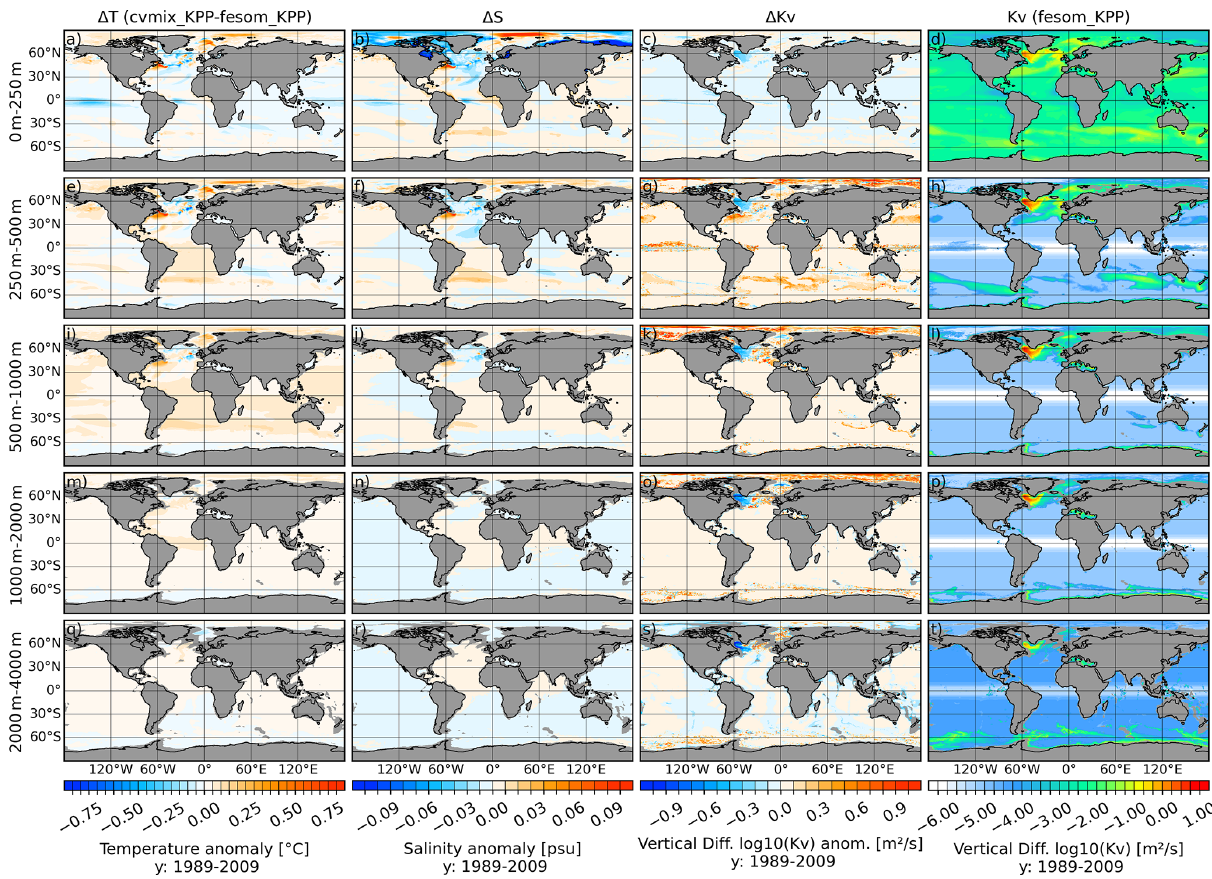
Figure 9. Temperature ( a, e, i, m, q ), salinity ( b, f, j, n, r ) and vertical diffusivity ( c, g, k, o, s ) difference between cvmix_KPP and the original fesom_KPP implementation, as well as the absolute vertical diffusivity values ( d, h, l, p, t ) for fesom_KPP averaged for the period 1989 to 2009. The panels show, from top to bottom, the vertically averaged fields for the depth ranges of 0–250, 250–500, 500–1000, 1000–2000 and 2000–4000m.